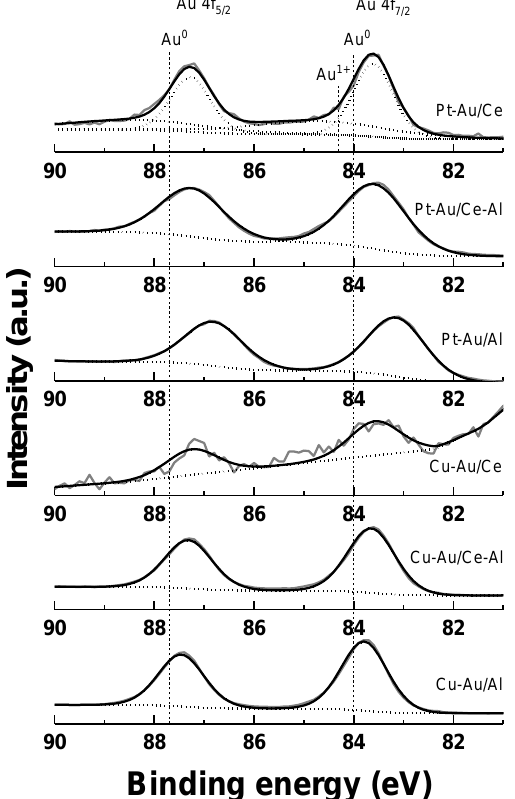
Figure 4. Au 4f spectra of all the studied catalysts (Au 0 , indicated in the figure, is the theoretical binding energy value of Au 0 ).